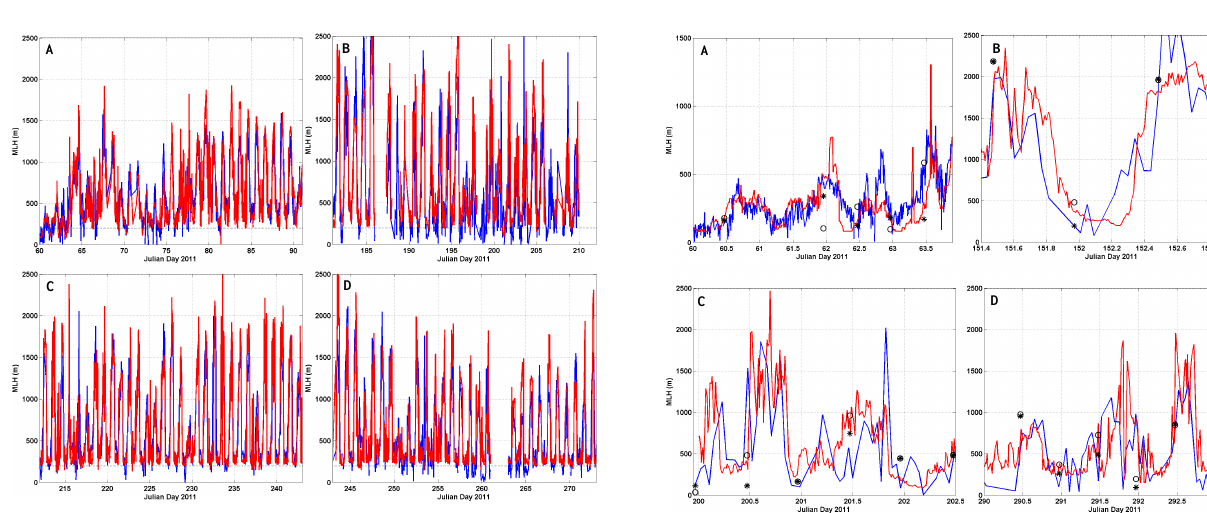
Figure 4: Short time series of MLH (m AGL) estimated from radiosonde profiles (black stars 3 Fig. 4. Short time series of MLH (ma.g.l.) estimated from ra- and circles indicating PTU and Rbn, respectively), lidar (red line) and MWR Tb (blue) 4 diosonde profiles (black stars and circles indicating PTU and Rbn, observations. Panel A: [60.0 – 64.0] corresponds to [March 1 st 00:00 UTC – March 5 th 00:00 5 respectively), lidar (red line) and MWR Tb (blue) observations. UTC]; Panel B: [151.4 – 153.0] corresponds to [May 31 th 09:36 UTC – June 2 nd 00:00 6 Panel A: [60.0–64.0] corresponds to [1 March 00:00UTC–5 UTC]; Panel C: [200.0 – 202.5] corresponds to [July 19 th 00:00 UTC – July 22 nd 12:00 7